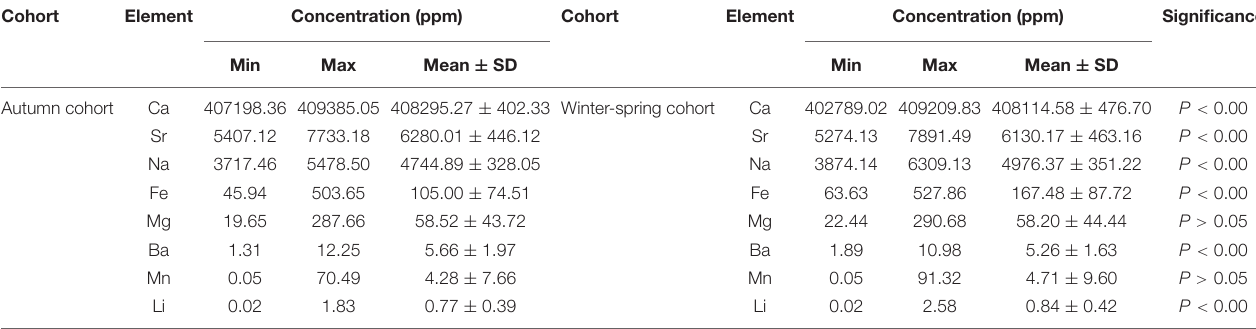
TABLE 3 | Element concentration in statolith of winter-spring and summer cohorts of Ommastrephes bartramii. Cohort Element Concentration (ppm) Cohort Element Concentration